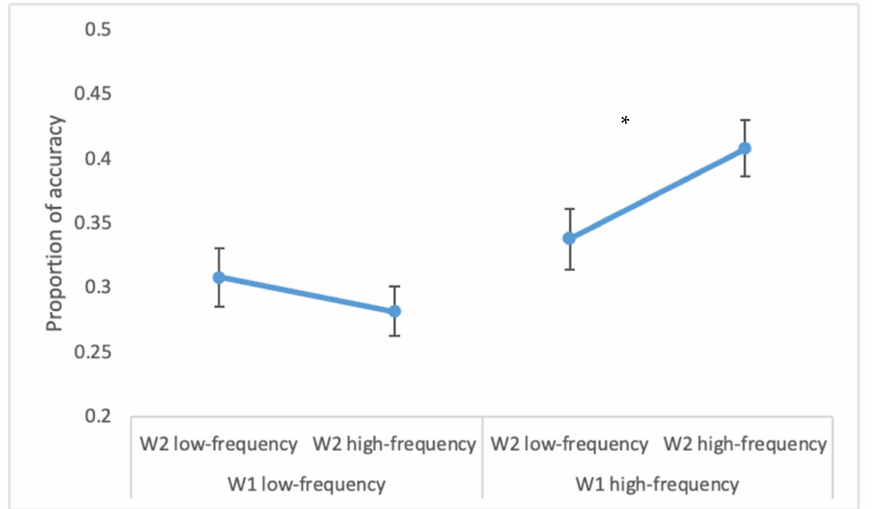
Figure 5. Experiment 3. Accuracy on W2 is reported in terms of the statistically significant interaction W1 frequency × W2 frequency. Bars represent standard errors. The asterisk (*) indicates statistically significant